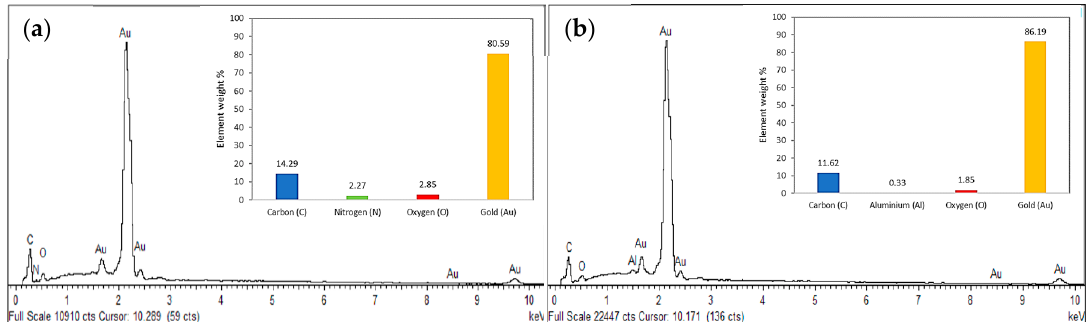
Figure 4. Energy Dispersive X-ray (EDX) spectrum showing the presence of gold elements and other bioorganic components in ( a ) AuNPs synthesised by E. elatior ; ( b ) AuNPs synthesised by sodium citrate. Insert graphs represent the elements distribution percentage in the samples.